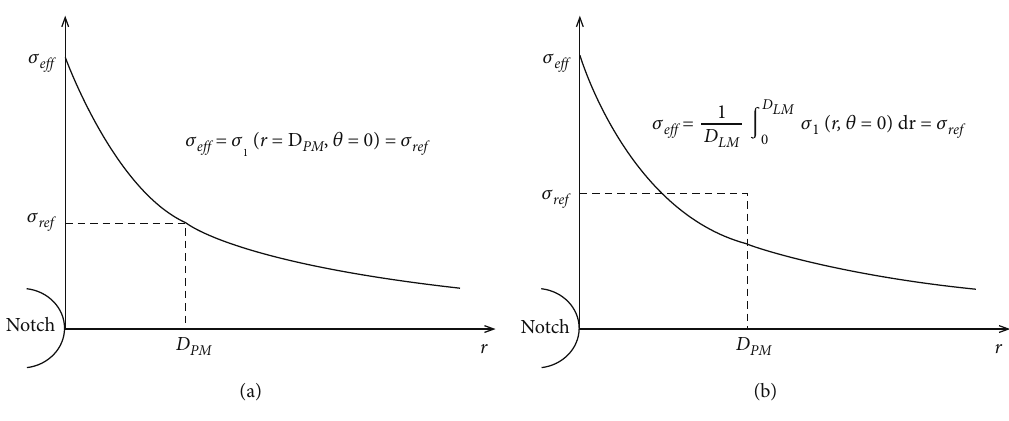
Figure 2: Schematic diagram of PM (a) and LM